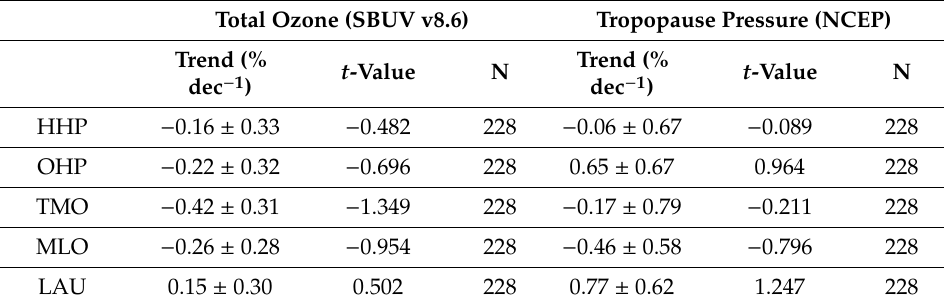
Figure 3. Time series of total ozone and tropopause pressure anomalies at lidar stations: Hohenpeissenberg and Haute Provence ( upper left ), Table Mountain ( upper right ), Mauna Loa ( lower left ) and Lauder ( lower right ). Table 4. Trends (% per decade) in total ozone from SBUV data and tropopause pressure from NCEP reanalysis data for the period 1998–2016, at five lidar stations, after removing variability related to the seasonal cycle and dynamical